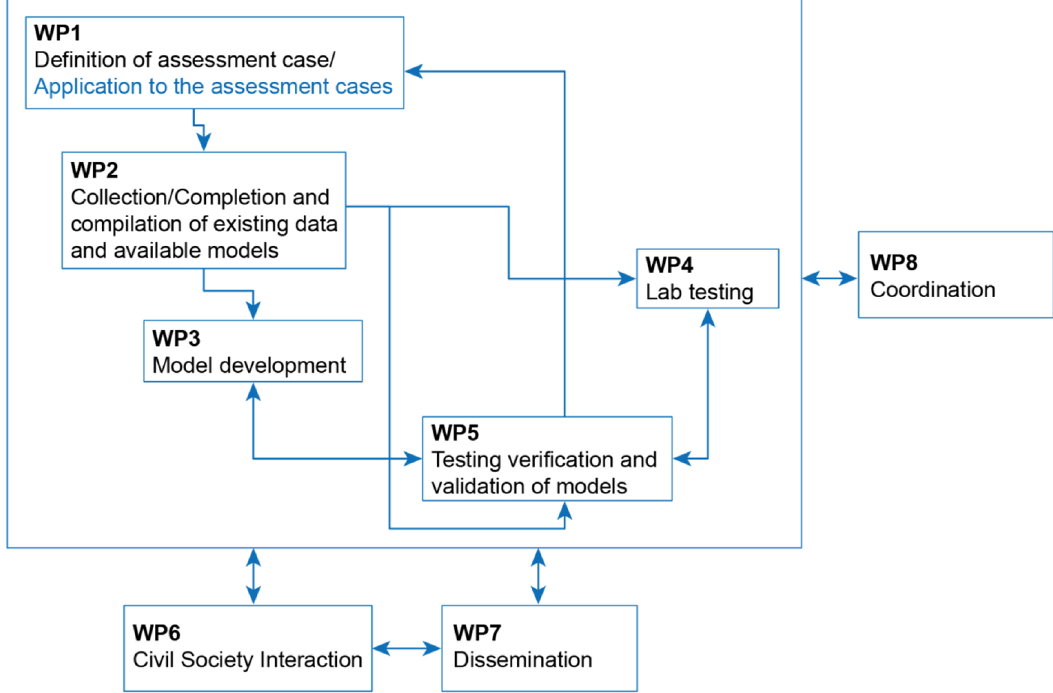
Fig. 4. Interconnections between the work packages in